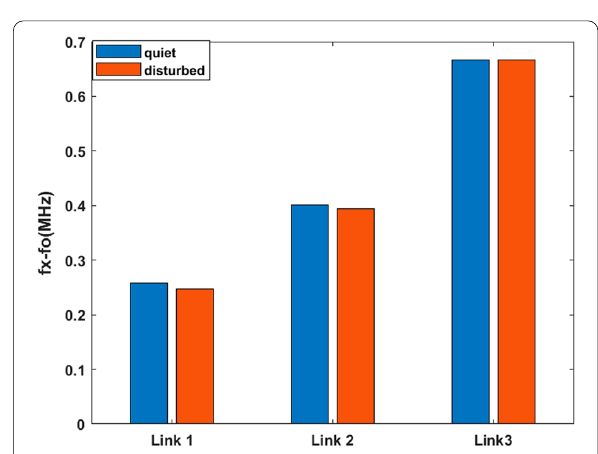
Fig. 7 Geomagnetic variability of the separations observed through three radio